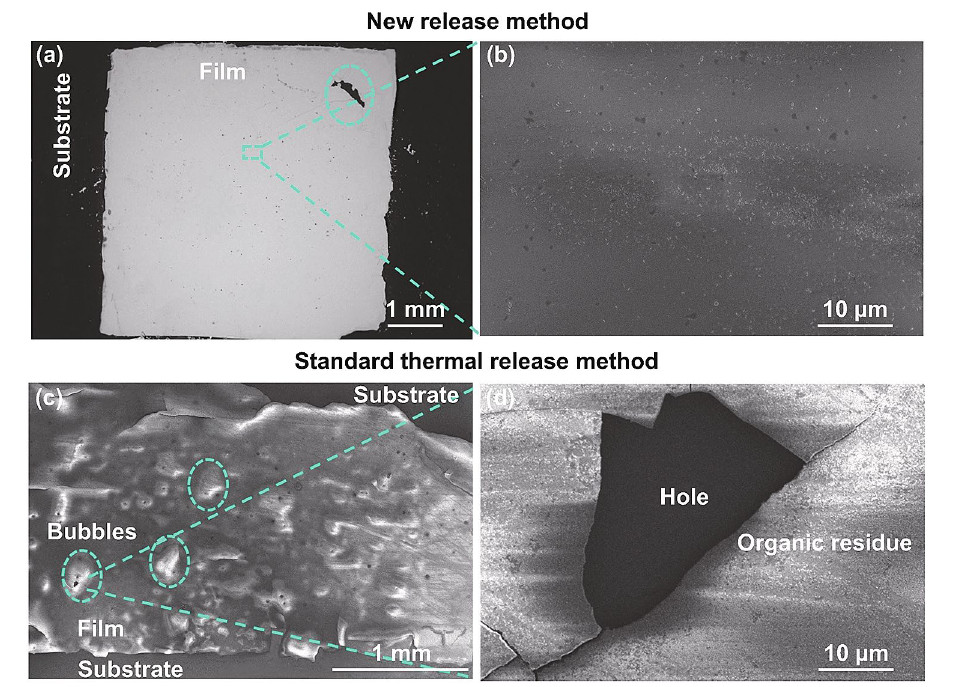
Fig. 3 a Image of the surface of a CeO 2 film (5 × 5 mm 2 ) transferred by the new optimized method IV of Figs. 1 and 2. b SEM image of the CeO 2 film. c Image of the surface of the film transferred by the thermal release tape assisted method III of Fig. 1. Bubbles due to heating pro‑ cess and cracks can be seen. d SEM image of the film. A thin layer of residual adhesives (white area) and a large hole can be seen. (Color figure